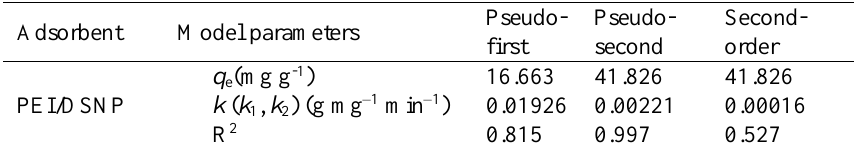
Table 2. The kinetic parameters for Pb 2+ ions adsorption on PEI/DSNPadsorbent